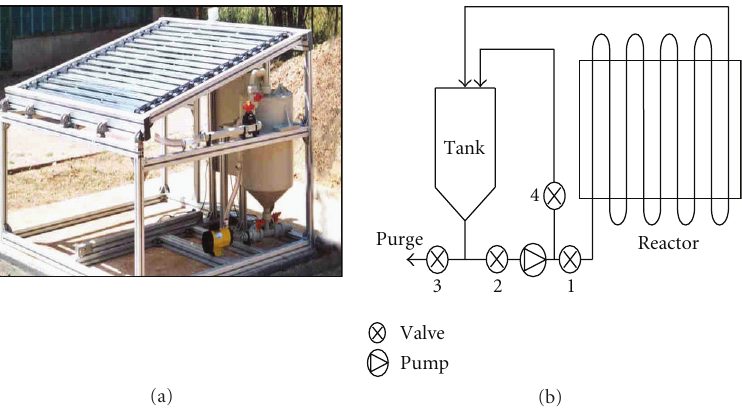
Figure 2: A Picture and the technical design of the CPC photoreactor.